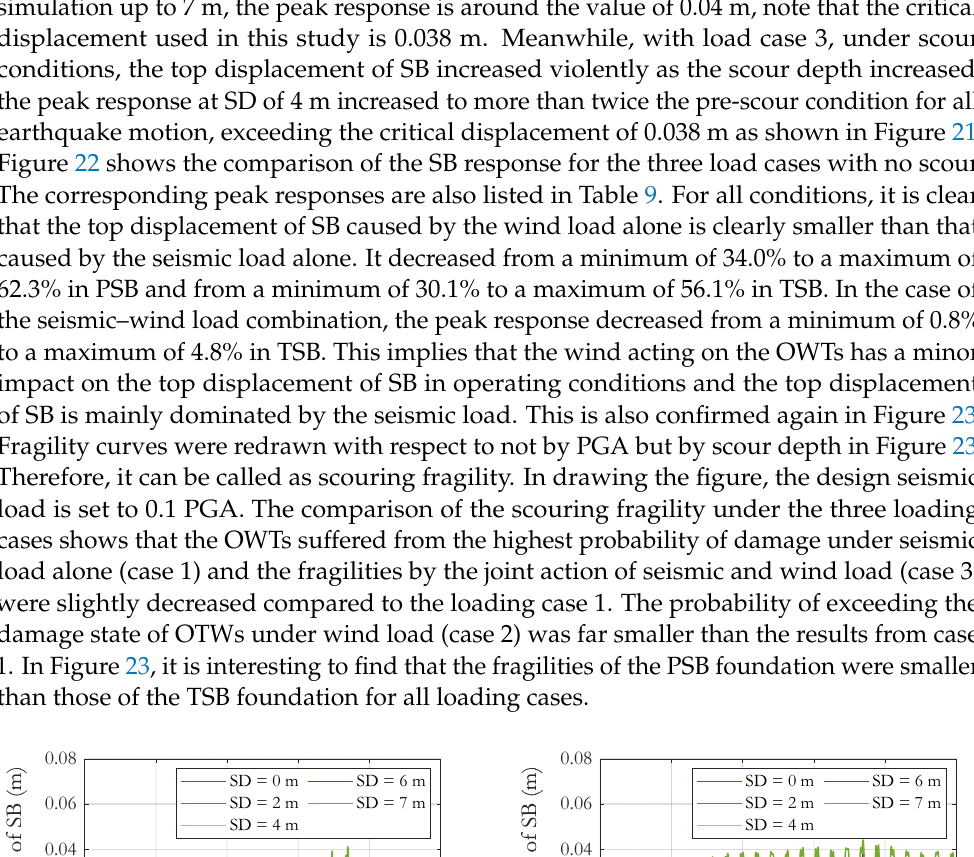
( a ) El Centro (left: PSB, right: TSB)